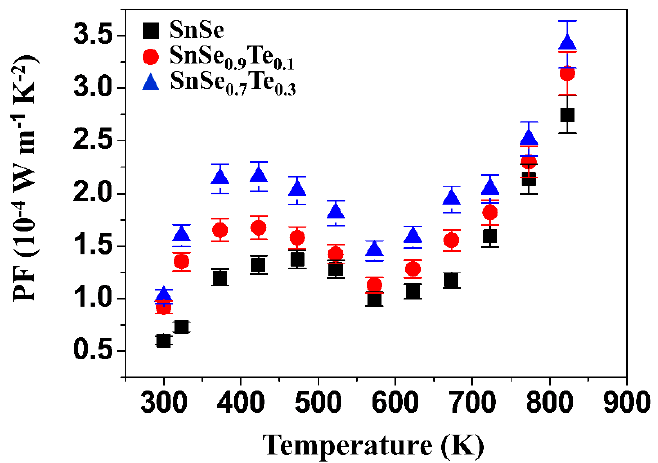
Figure 8. The power factor (PF) of the polycrystalline SnSe 1 − x Te x (x = 0, 0.1 and 0.3) obtained at different temperatures.